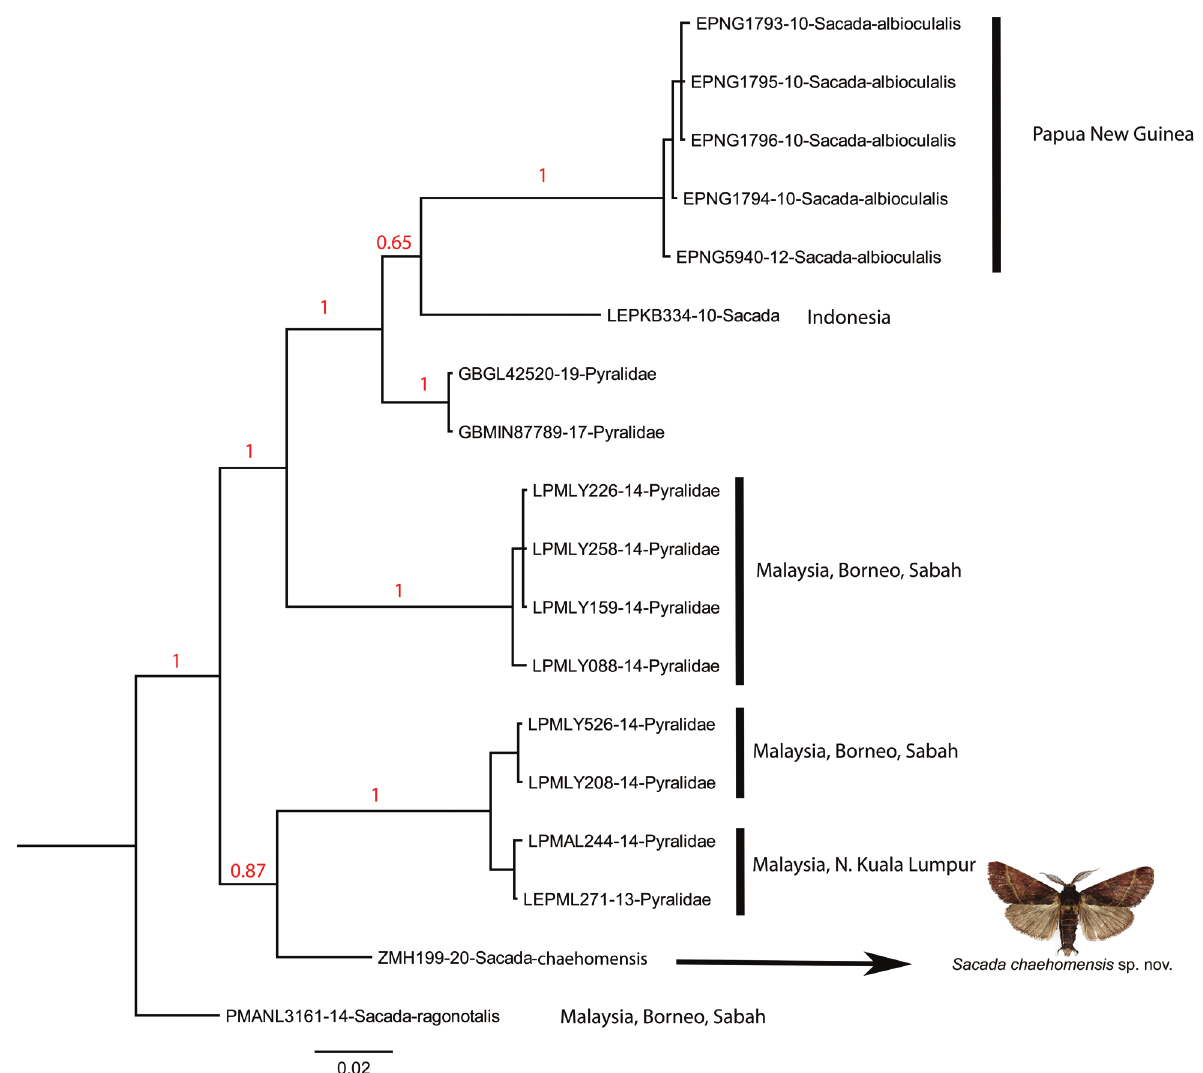
Figure 10. The Bayesian tree from analysis of the COI5P sequences of Sacada chaehomensis sp. nov. and 17 public Sacada DNA sequences. The nodes are scored by posterior probabilities